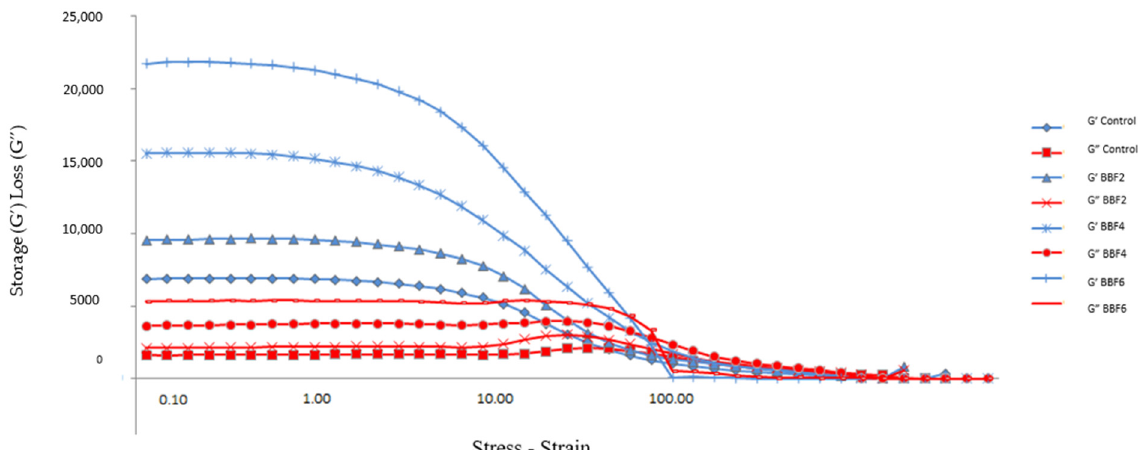
Figure 3. Rheological properties (strain-sweep test) of chicken batter with the addition of Berangan banana peel. Abbreviations: SBF2: Added 2% Saba banana peel; SBF4: Added 4% Saba banana peel; SBF6: Added 6% Saba banana peel; BBF2: Added 2% Berangan banana peel; BBF4: Added 4% Berangan banana peel; BBF6: Added 6% Berangan banana peel. Data for SBF2, SBF4 and SBF6 adapted from [4].